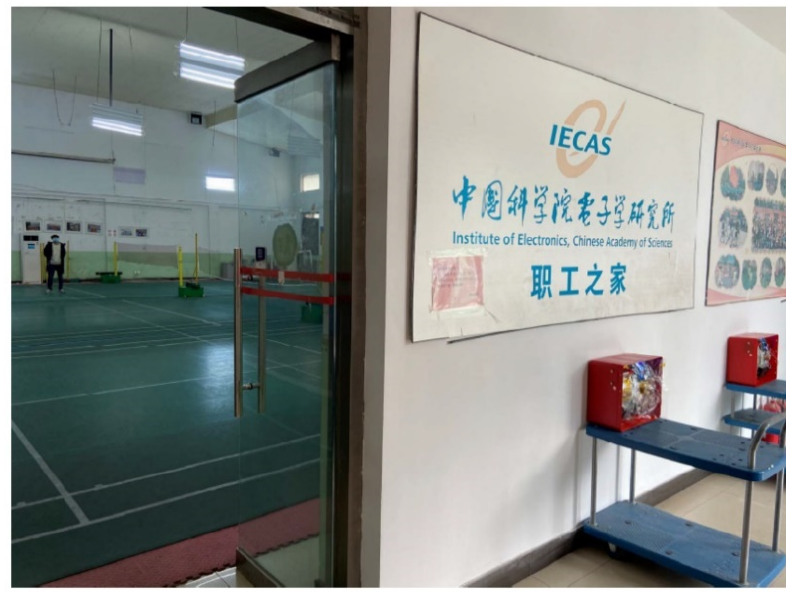
Figure 12. The type-II experimental setup. Figure 13a,b shows the output range-frequency images of the normal FFT-based respiration detection methods using the echoes from a single radar. Due to the low SNR in this experimental scene, the output range-frequency images are too noisy to distinguish the vital sign feature (VSF).